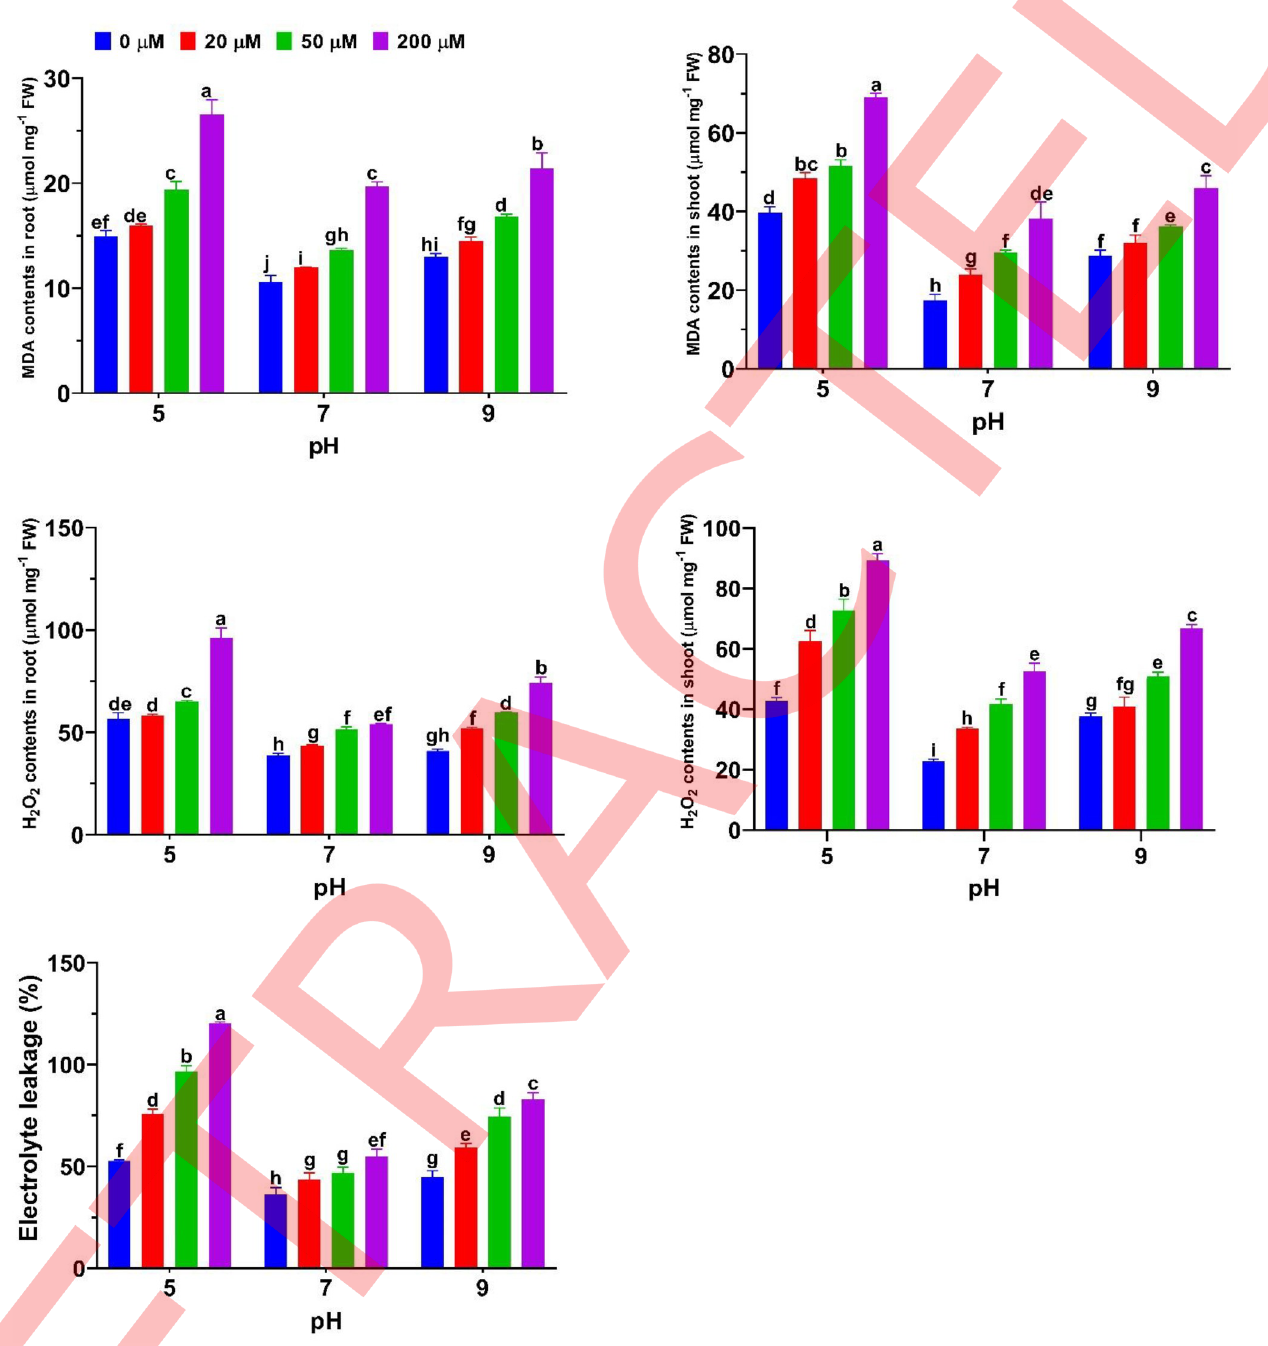
Fig 4. Effect of three different levels of pH (5, 7, and 9) on roots and shoots hydrogen peroxide (H 2 O 2 ), malondialdehyde (MDA), and electrolytic leakage (EL) contents of cadmium (0, 20, 50, and 200)-stressed wheat plants. concentration (200 μ mol L -1 ) in the growing medium at all levels of pH caused a highly signifi- cant decline in all macro and microelements (N, P, K, Ca, Mg and Zn) concentrations, but the optimum pH for the reduction was recorded at pH 5. The reduction of N at pH 5 along with